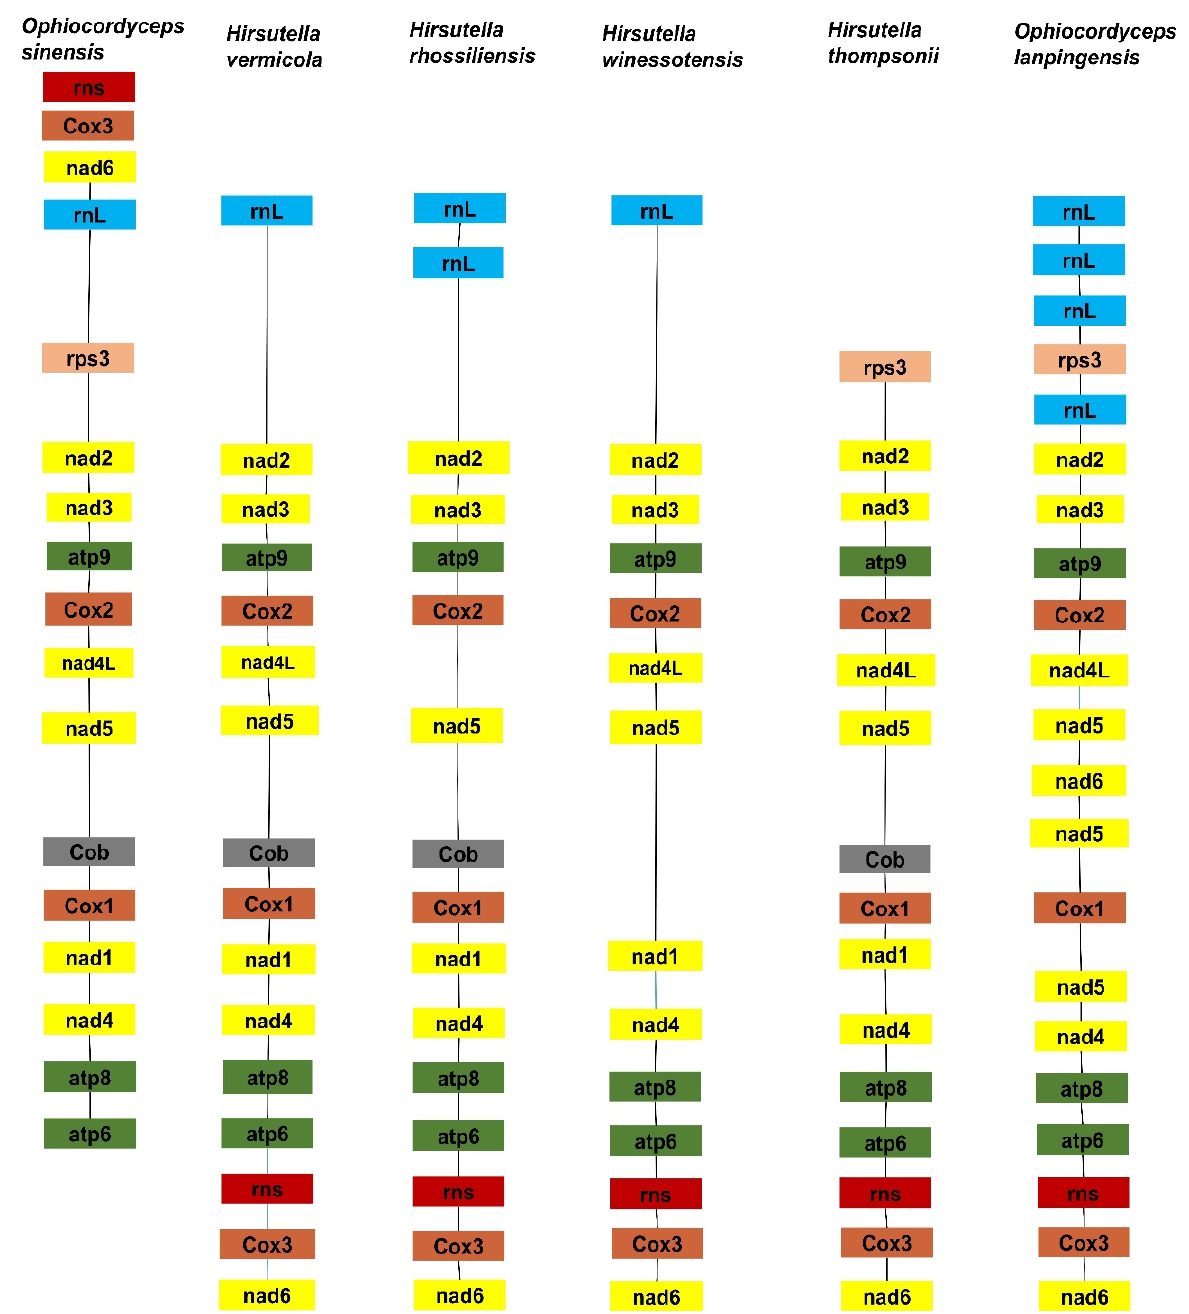
Figure 7. The gene arrangement of mitogenomes of O. lanpingensis and other related